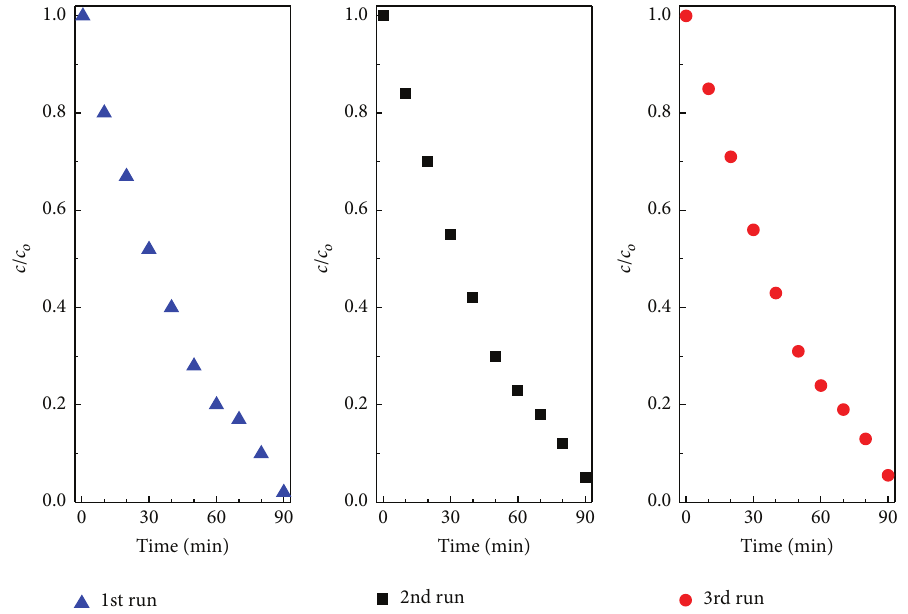
Figure 8: Reusability test by recycling 1.2% G-BWO composite three